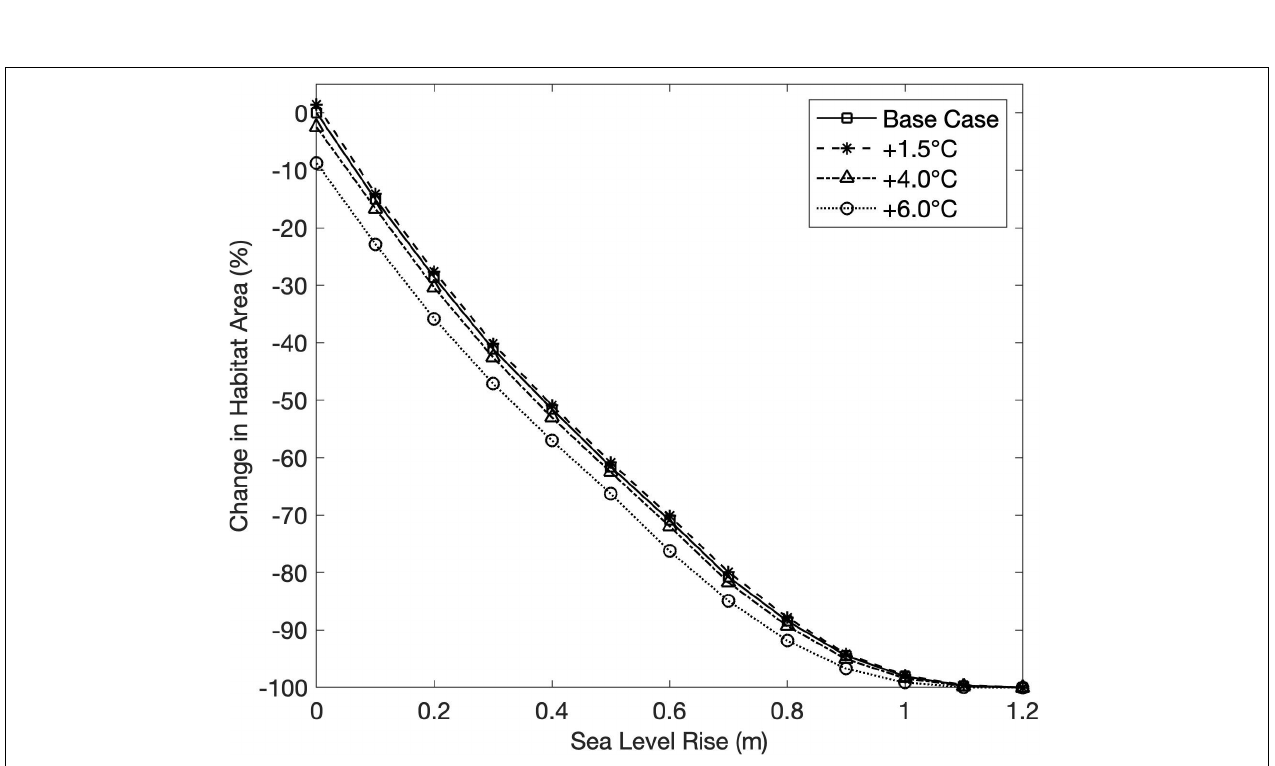
FIGURE 4 | Change in habitat area from the base case scenario for all sea level rise (SLR) scenarios, under four temperature rise scenarios.